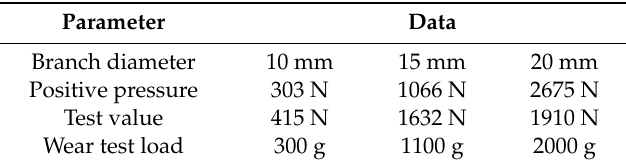
Figure 16. The actual force of static pressure shearing of branches. Table 6. Theoretical and experimental shear